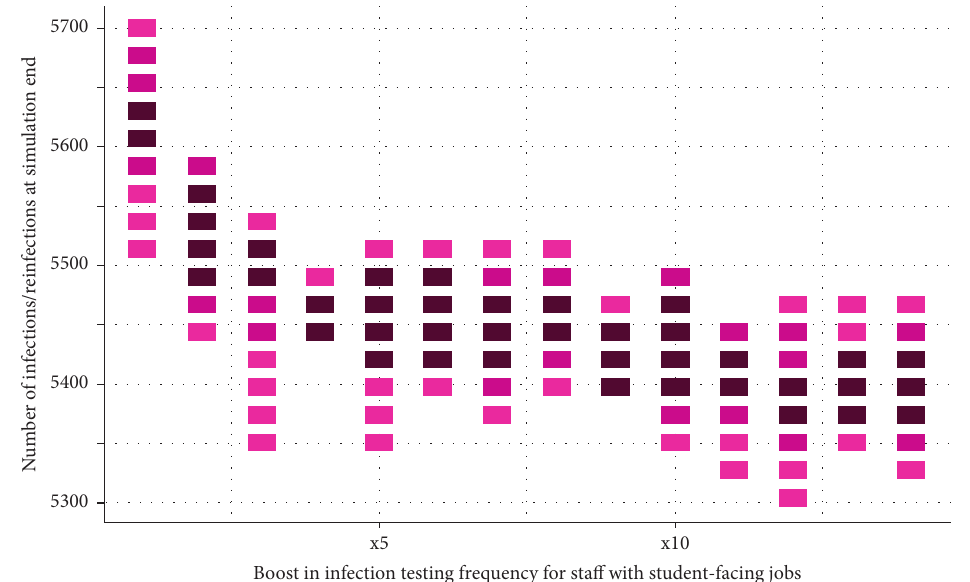
Figure 5: The number of infections (or reinfections) against the factor of testing frequency increases for staff with student-facing jobs. Numerous runs are binned and the color indicates clustering of runs, with darker colors corresponding to a greater number of runs.